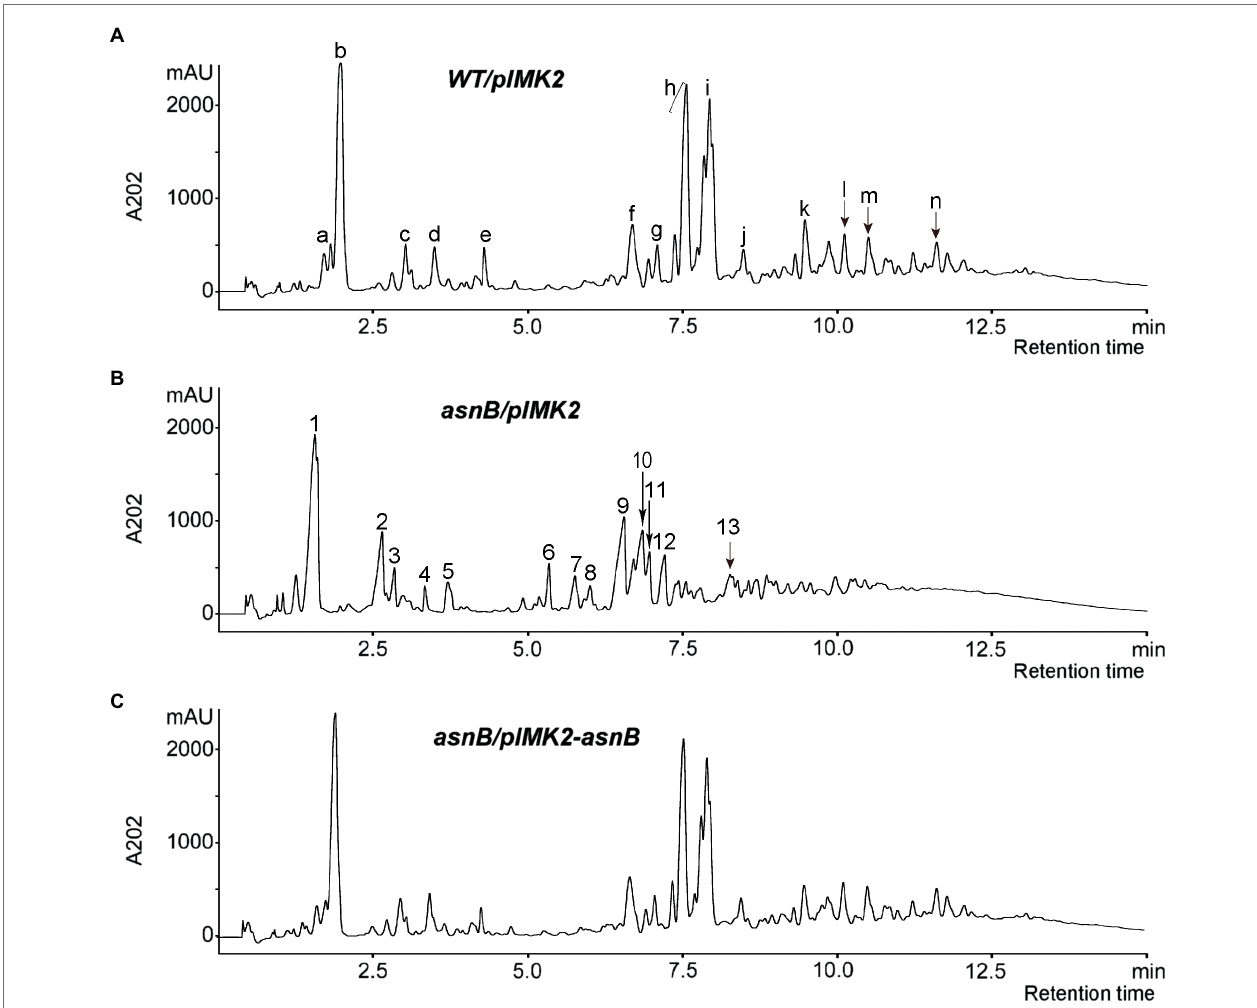
FIGURE 6 | RP-HPLC chromatograms of muropeptides generated by mutanolysin hydrolysis of PG from (A) WT/pIMK2 , (B) asnB/pIMK2 , and (C) asnB/pIMK2- asnB . The major muropeptide peaks of the chromatogram are annotated with letters and numbers for WT/pIMK2 and asnB/pIMK2 , respectively. The mass and identity of the labeled peaks are listed in Supplementary Table S2 . Disaccharide tripeptides identified in peak b of WT/pIMK2 and peak 1 of asnB/pIMK2 were further analyzed by MS–MS ( Supplementary Figure S1